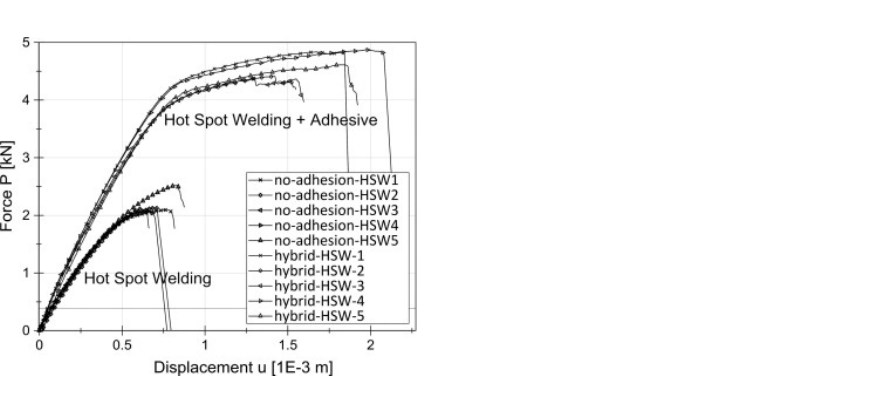
Figure 8. Experimental force–displacement diagrams of the spot weld joints and the hybrid joints (combining spot welding and adhesive bonding) [90]. (combining spot welding and adhesive bonding)